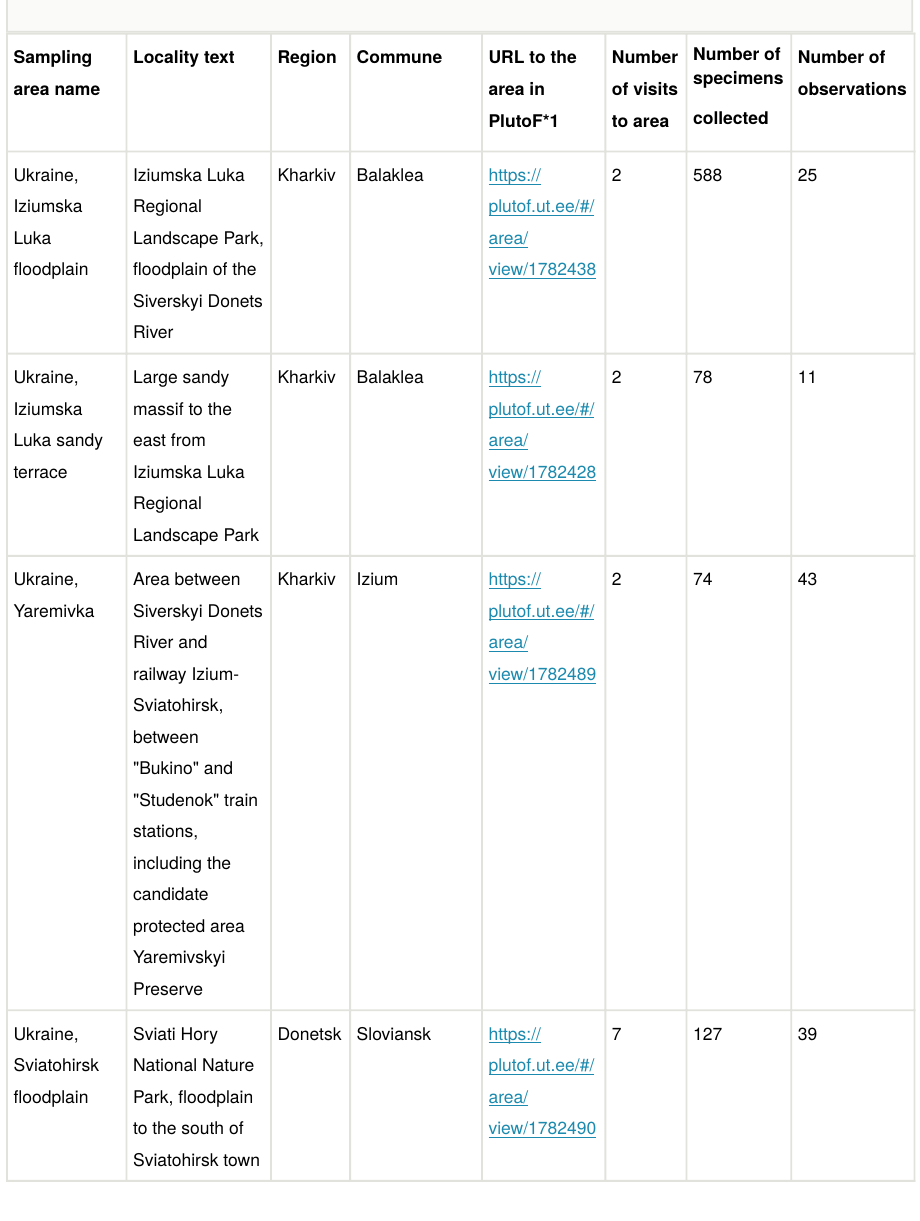
Table 1. De fi nitions of 16 sampling areas in eastern Ukraine where aphyllophoroid fungi were inventoried, with number of visits and taxa